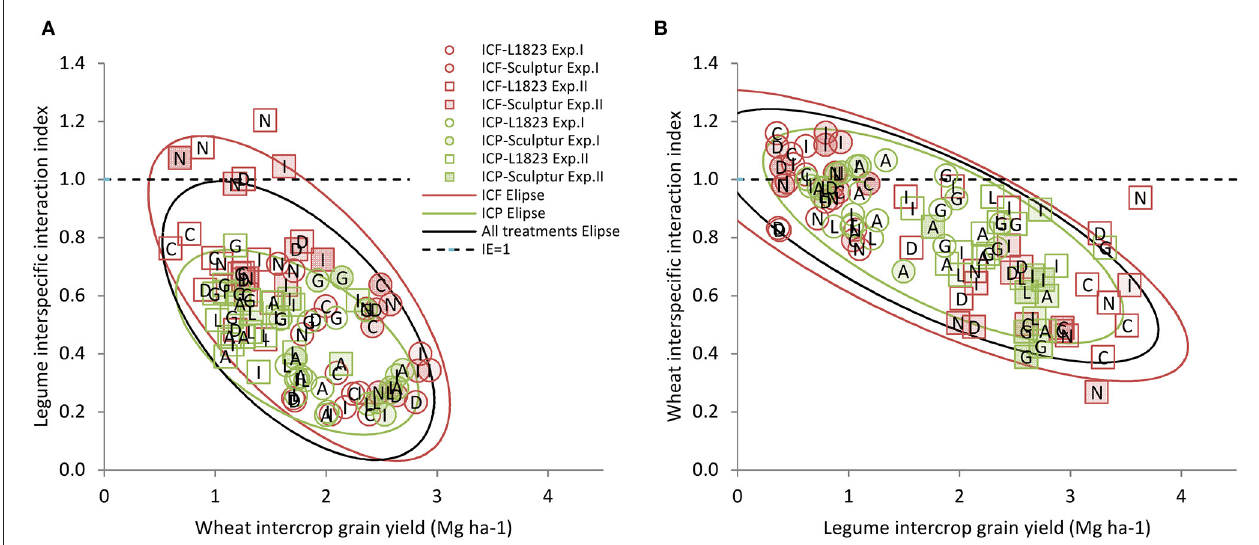
FIGURE 5 | Relationship between interspecific interaction index and the associated species yield. The IE was calculated from the grain yields for legumes (A) and for wheat (B) as a function of the yield of the associated species (Mg ha − 1 ). The symbols correspond to ICF (red), ICP (green), Exp.I (circles), Exp.II (squares), L1823 wheat cultivar (open), and Sculptur wheat cultivar (closed). The ellipses represent the prediction interval at p = 0.90 in red for ICF, in green for ICP, and in black for both ICF and ICP. Each point corresponds to a single replicate data. It should be borne in mind the inverse relationship between the IE index values and the levels of interspecific competition effects, respectively, i.e., the lower the IE index value for a species, the stronger its sensitivity to the interspecific competition within the crop